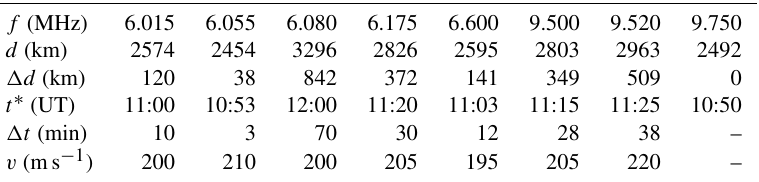
Table 4. Distances d over which TIDs traveled at apparent speeds v and arrived at the propagation pass midpoints from the center of Typhoon Kong-rey with relative time delays (cid:49)t at the UT moments t ∗ .